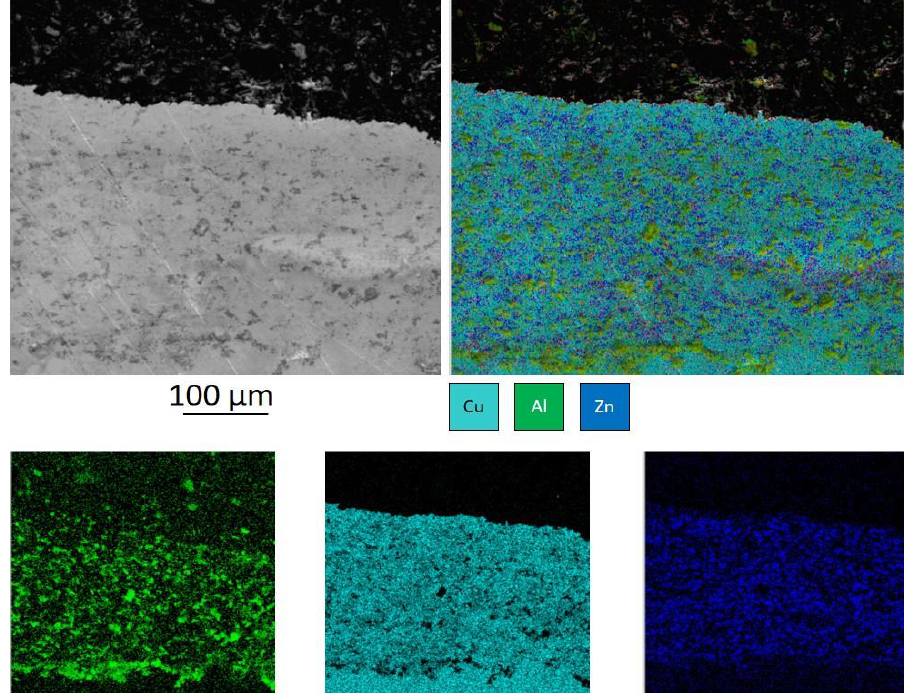
Figure 14. Microstructure and distribution maps of the elements of the substrate and the Cu-60% Al 2 O 3 -10% Zn coating remaining on it after the coating was tearing off from the substrate with pre- liminary